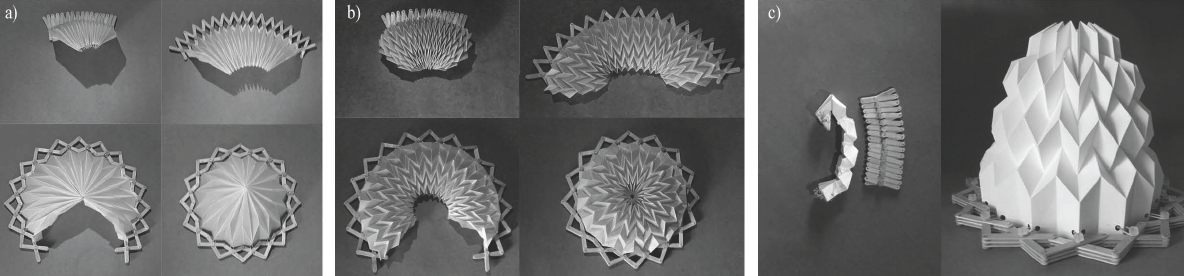
Figure 15: Deployment sequences of: a) a yoshimura CP deployable dome and b) an arc-miura CP deployable shell. c) A modified